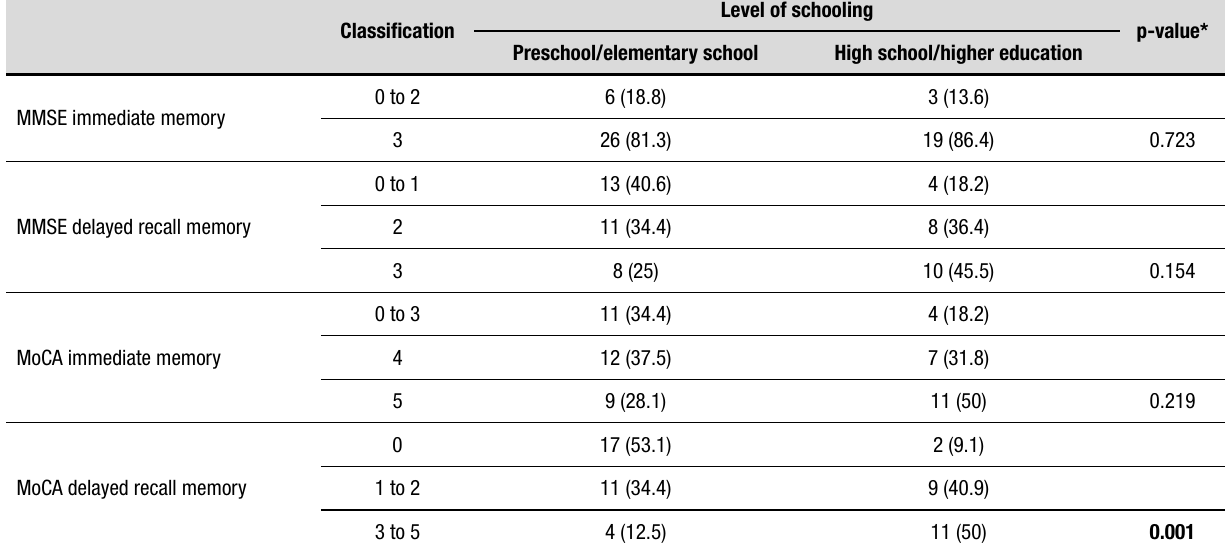
Table 4. Schooling × immediate delayed recall memory